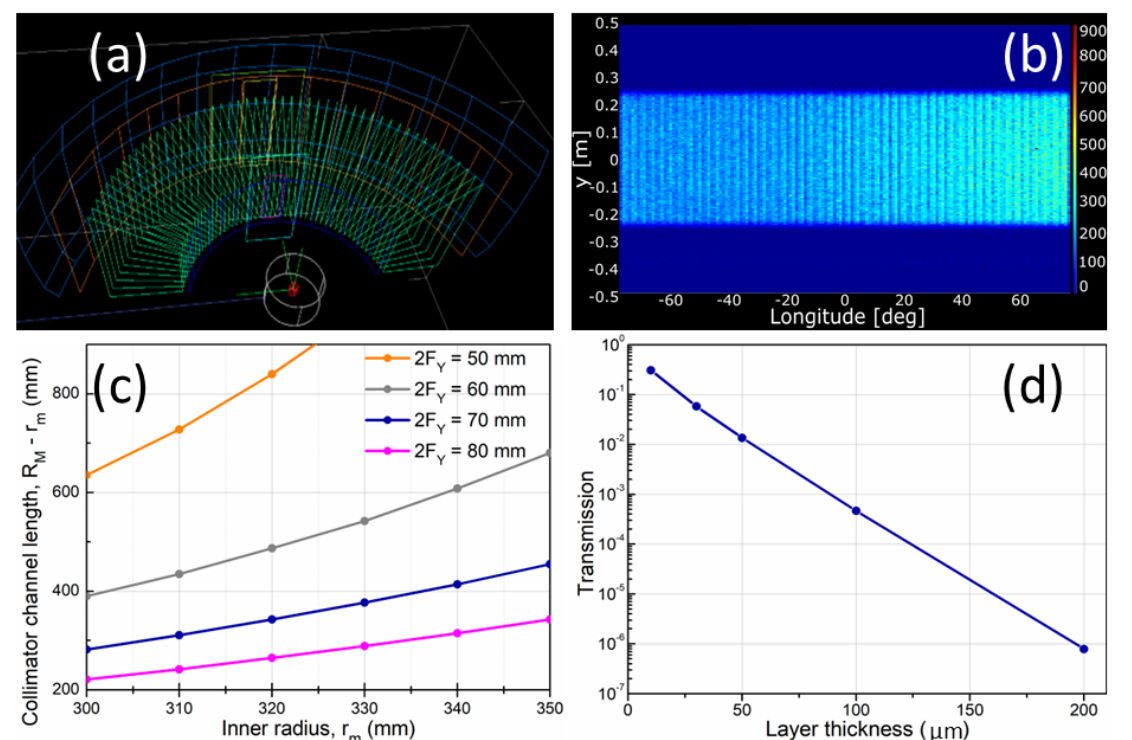
Fig. 6. (a) McStas visualization of the radial collimator for MIRACLES (b) Signal collected by a McStas position sensitive monitor at the exit of the collimator in the forward scattering (c) Collimation length (that can serve or relative comparison of ROC dimensions and cost) as a function of the inner radius and focal length; (d) Thermal neutron absorption factor (1/attenuation factor) of a Gd layer as a function of the layer thickness, obtained by